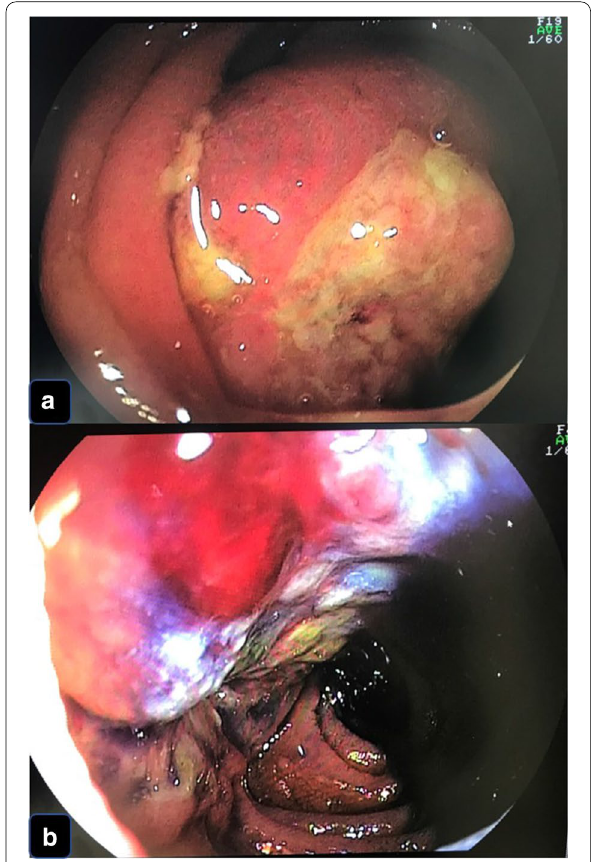
Fig. 2 Findings of double-balloon endoscopy. a , b Primary tumor looked like submucosal tumor accompanied by an ulcer